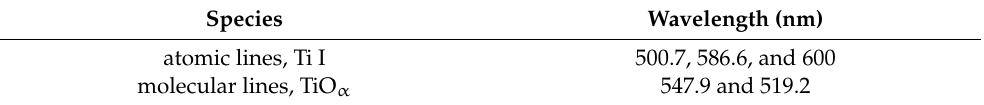
Table 3. OES data with the corresponding species elements; wavelength for the TiO 2